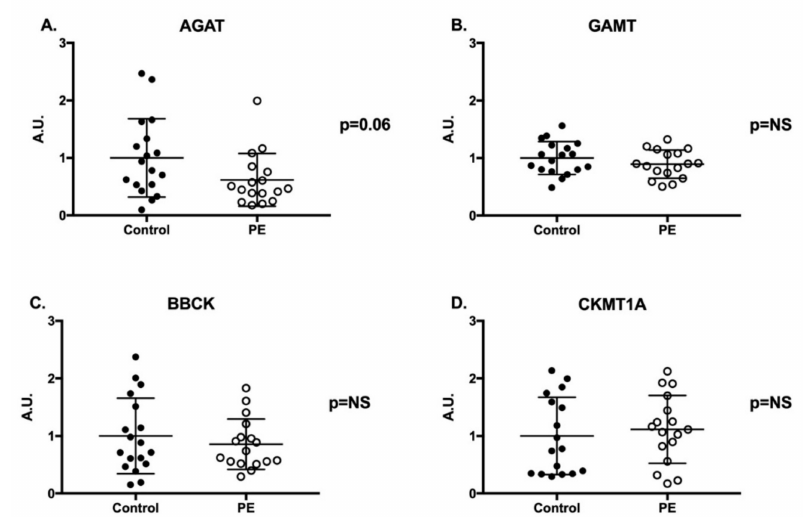
Figure 3. Placental Protein Expression of the Creatine Synthesizing Enzymes and Kinases. Creatine synthesis enzymes AGAT ( A ) and GAMT ( B ), cytosolic creatine kinase BBCK ( C ) and mitochondrial creatine kinase CKMT1A ( D ). n = 19 normotensive control (closed circle) and n = 19 PE (open circle). Data were normalized to total protein and a control sample run across blots. Data are expressed in arbitrary units (A.U.) relative to the control cohort. Wilcoxon Rank Sum was used for statistical comparison. Significance was set at p ≤ 0.025, following a Benjamini-Hochberg adjustment for false-positives.